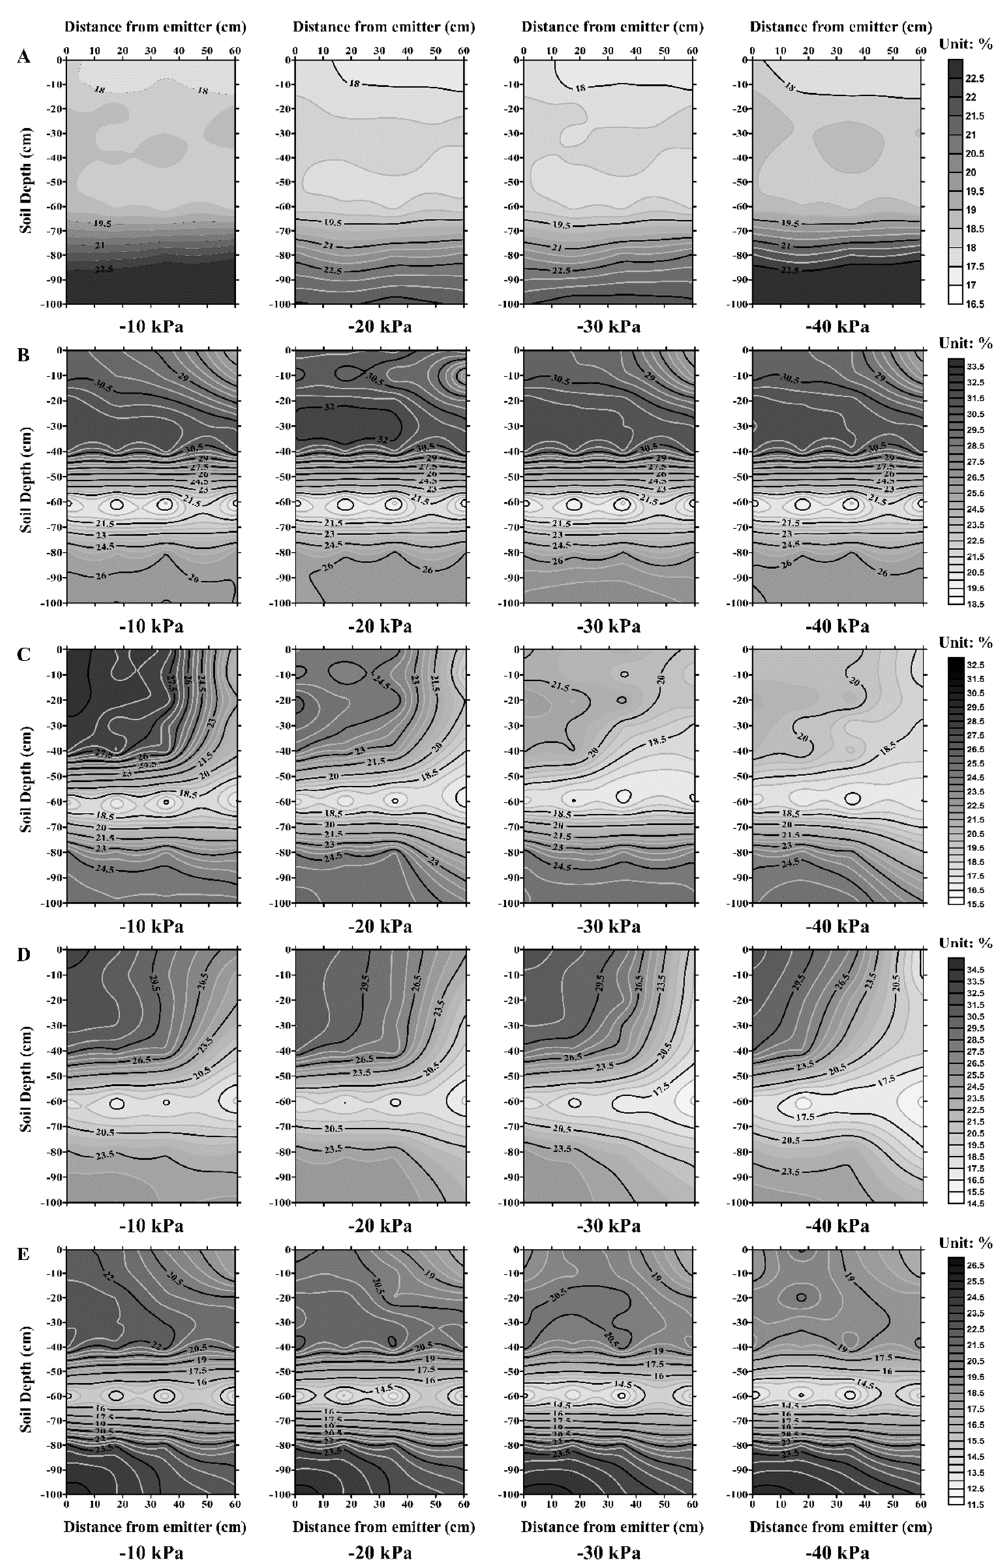
Figure 7. Spatial distribution of soil moisture along the vertical transect that is perpendicular to the drip line ( A ) before spring irrigation, ( B ) before sowing, ( C ) before the irrigation at the jointing stage, ( D ) after the irrigation at the jointing stage, and ( E ) after harvest, for all treatments in 2016.